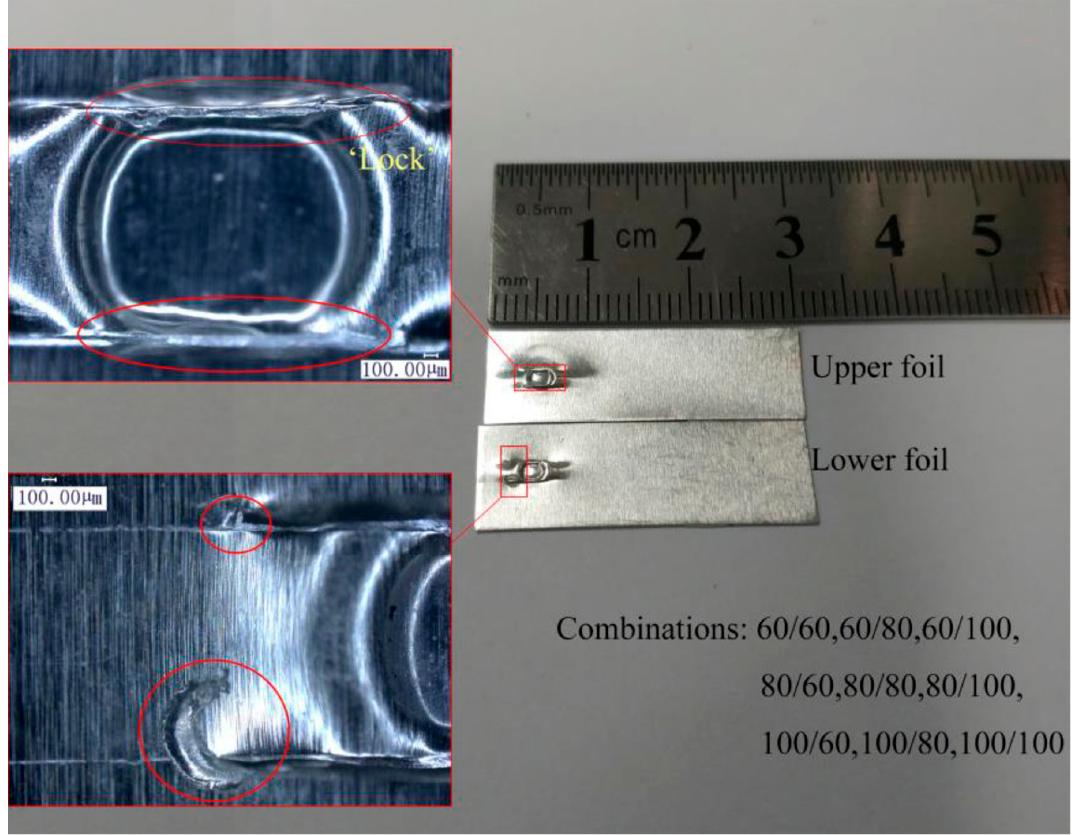
Figure 27. Failure mode of the parallel shear strength test.